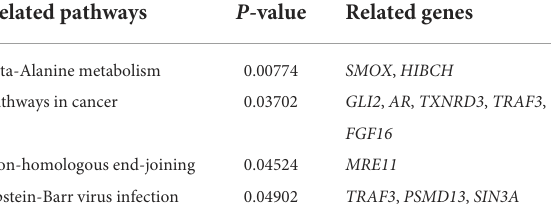
TABLE 1 Four significantly enriched KEGG